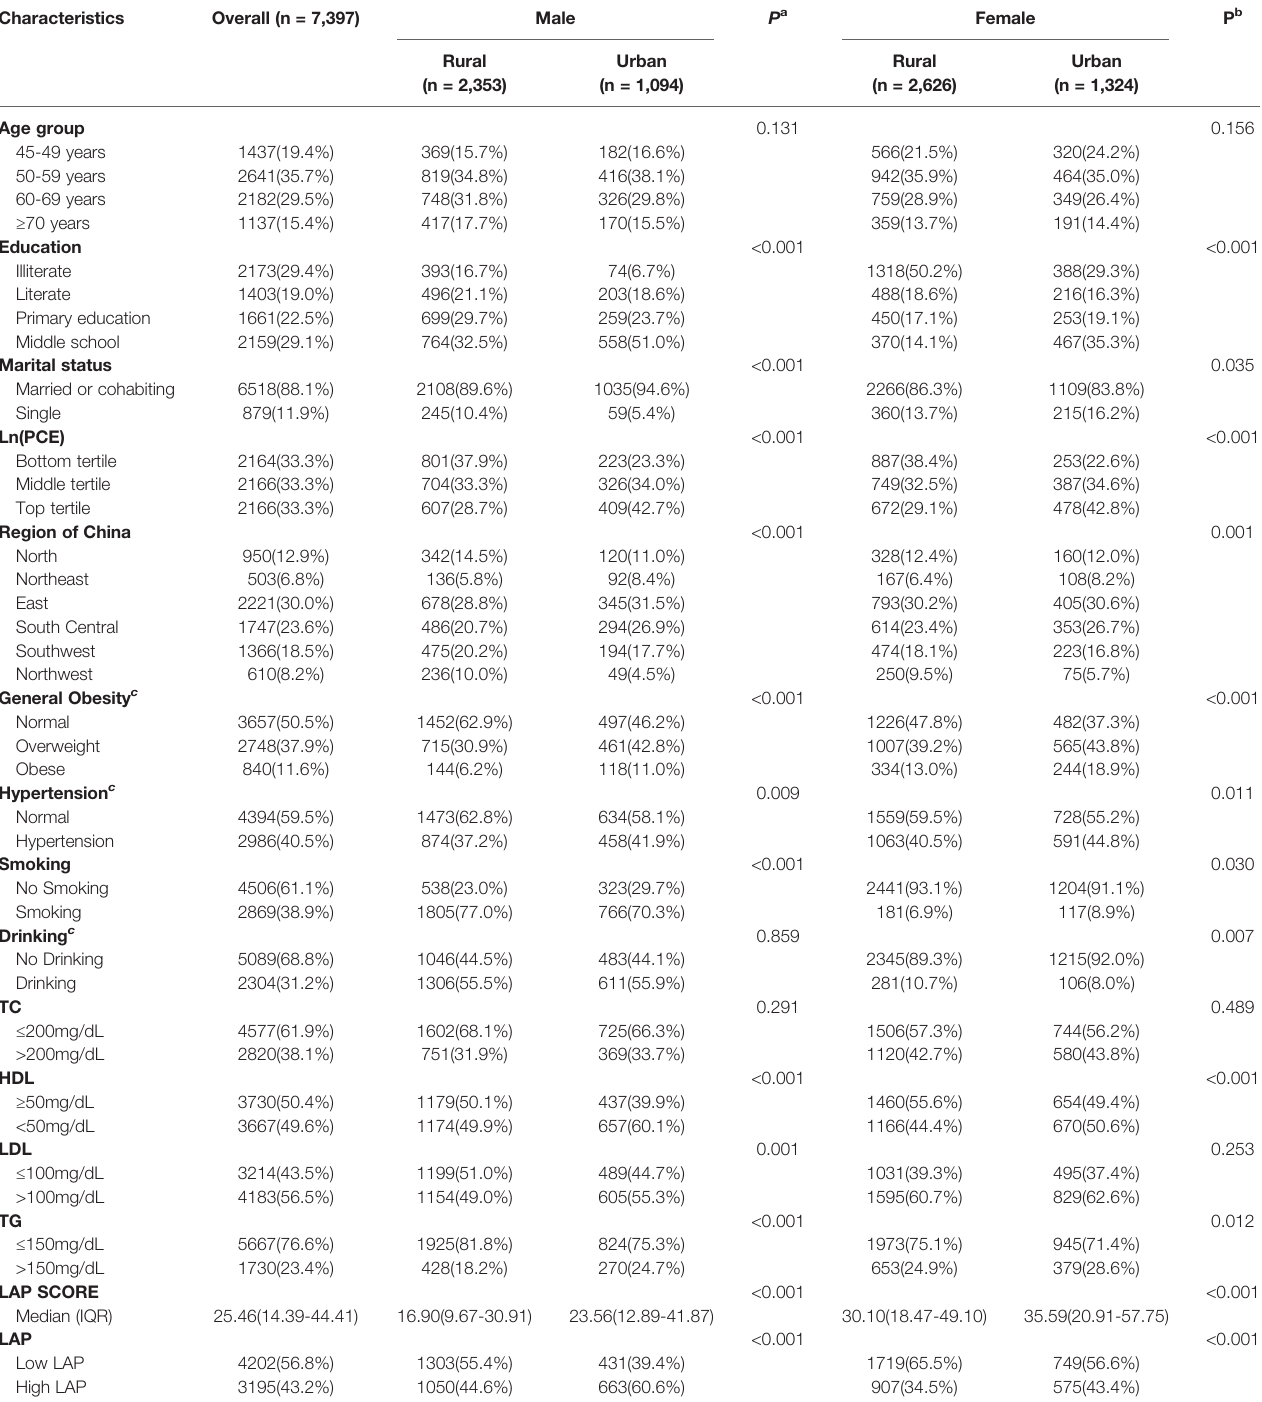
TABLE 1 | Demographic, socioeconomic and geographic characteristics of the included participants at baseline (CHARLS